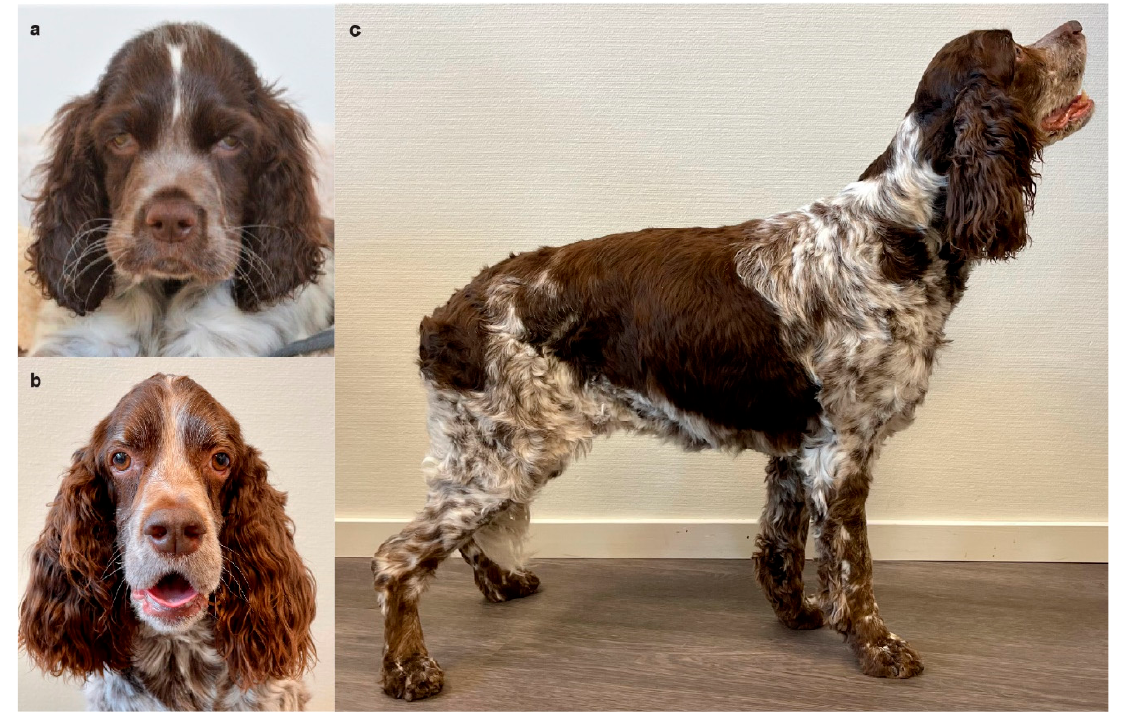
Figure 2. Affected English springer spaniel Dog #1 ( a ) as a puppy and ( b , c ) at seven years of age, showing severe temporal and pelvic limb muscle atrophy. Additionally noted are the wider positioning of the eyes, drooping lips, lower placement of the ears, and tilted stance. Table 1. Hematology results for affected, related, and unrelated ESSP dogs from Sweden with dyserythropoietic anemia and myopathy